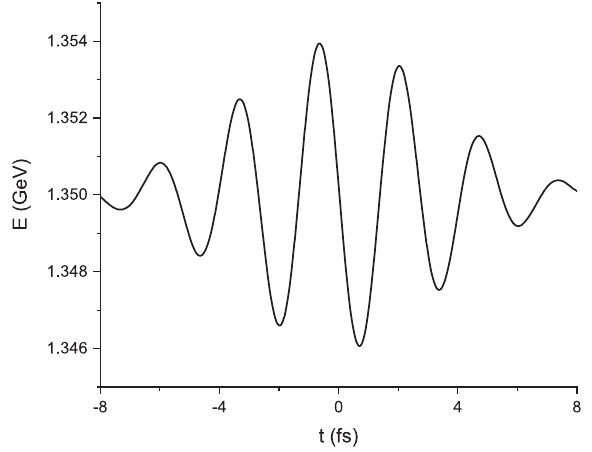
FIG. 2. Energy modulation induced by the laser. Bunch head is on the left